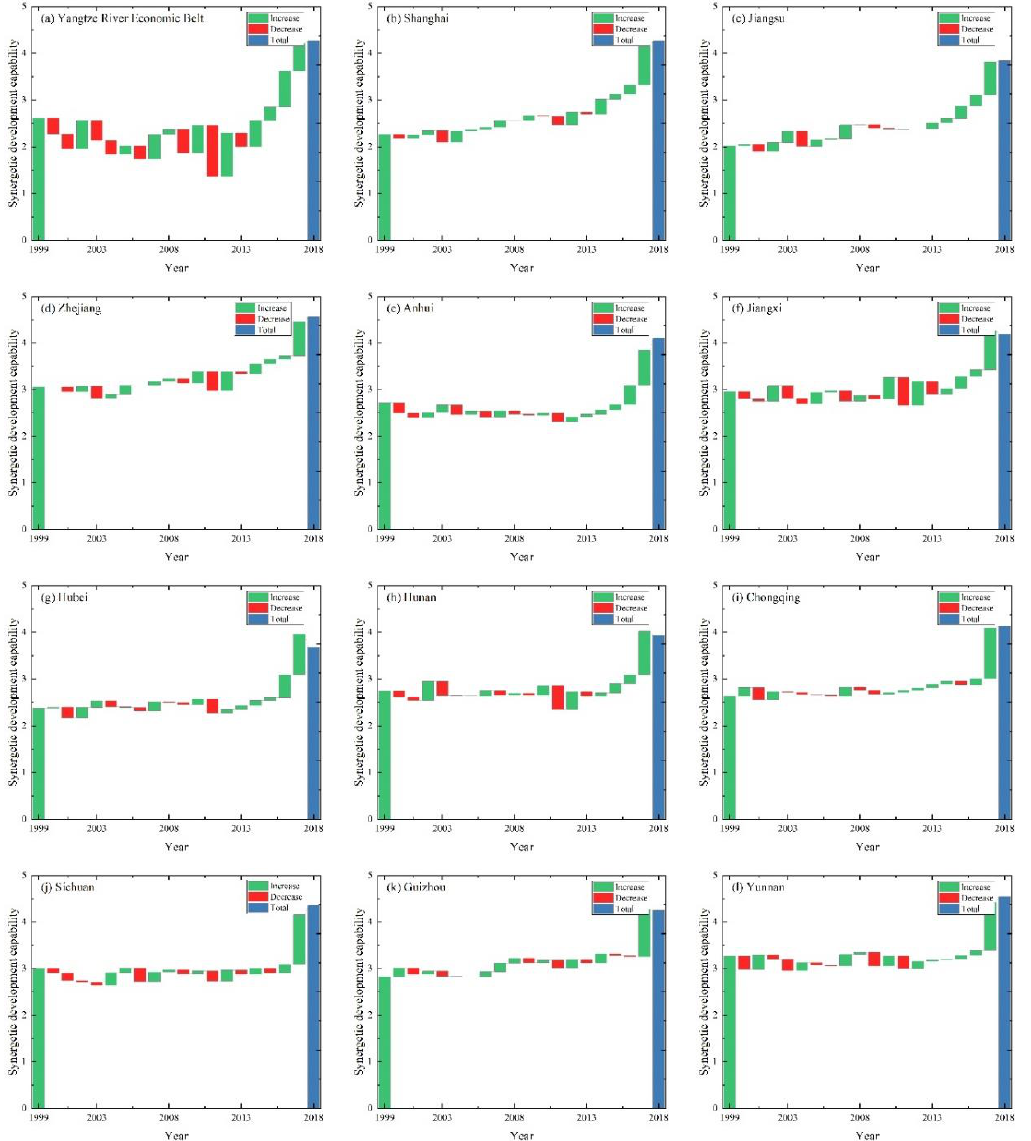
Figure 6. The synergetic development capability of the coupling system in 11 provinces from 1999 to 2018.